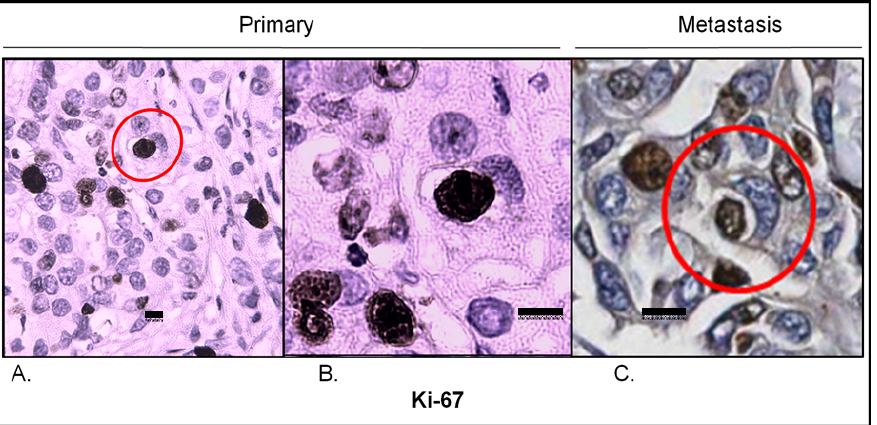
Figure 7. Ki67 expression in the primary lesion and lymph node metastasis. ( A ) Primary lesion: Ki67 hotspot; the red circle indicates an entotic figure with a Ki67 ‐ positive inner cell; 10× microscope objective. ( B ) A selected part of the Ki67 hotspot from panel A displaying a Ki67 ‐ positive inner cell in an entotic figure; 40× microscope objective. ( C ) Lymph node metastasis: Ki67 hotspot; the red circle indicates an entotic figure with a Ki67 ‐ positive inner cell; 20× histological scan. Scalebar 10 μ M.